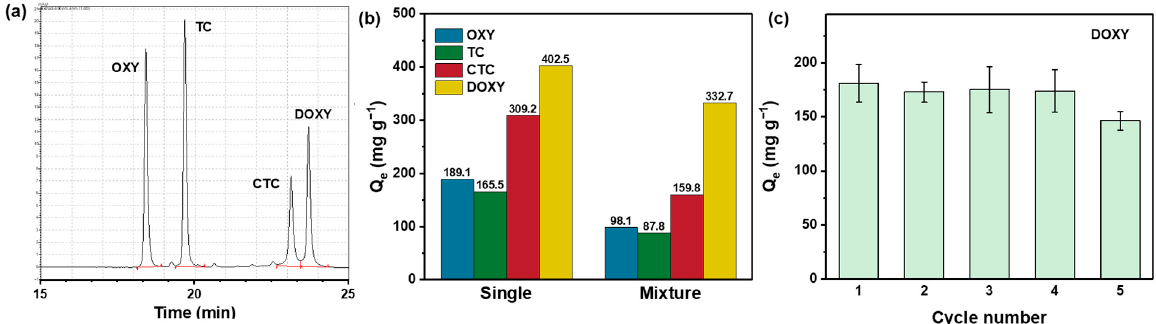
Figure 11. ( a ) HPLC chromatogram of 10 mg/L OXY, TC, CTC and DOXY standard solution; ( b ) OXY, TC, CTC, and DOXY single ‐ drug adsorption and their competitive mixture adsorption by SA– DCNC ‐ 40 hydrogel beads ( C 0 = 500 mg L − 1 , pH = 7); ( c ) recyclability of SA–DCNC ‐ 40 hydrogel beads for DOXY